Question: Provide a one-line summary of what is displayed.
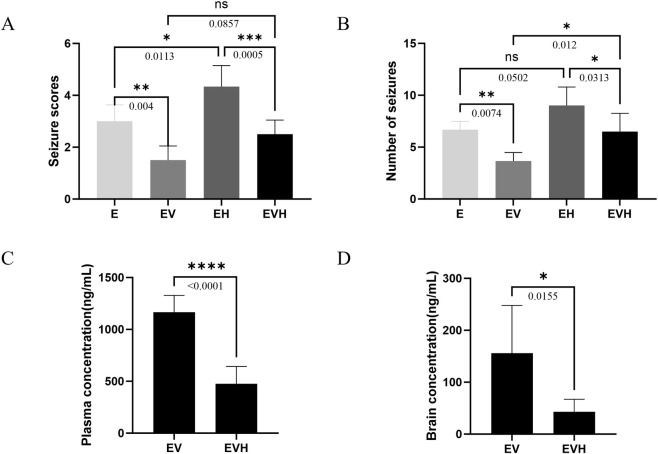
Answer: (A) Seizure scores (B) number of seizures (C) plasma concentration of VPA, and (D) brain concentration of VPA. Data are presented as mean ± SD (n = 6). *P < 0.05, **P < 0.01, ***P < 0.001, and ****P < 0.0001.